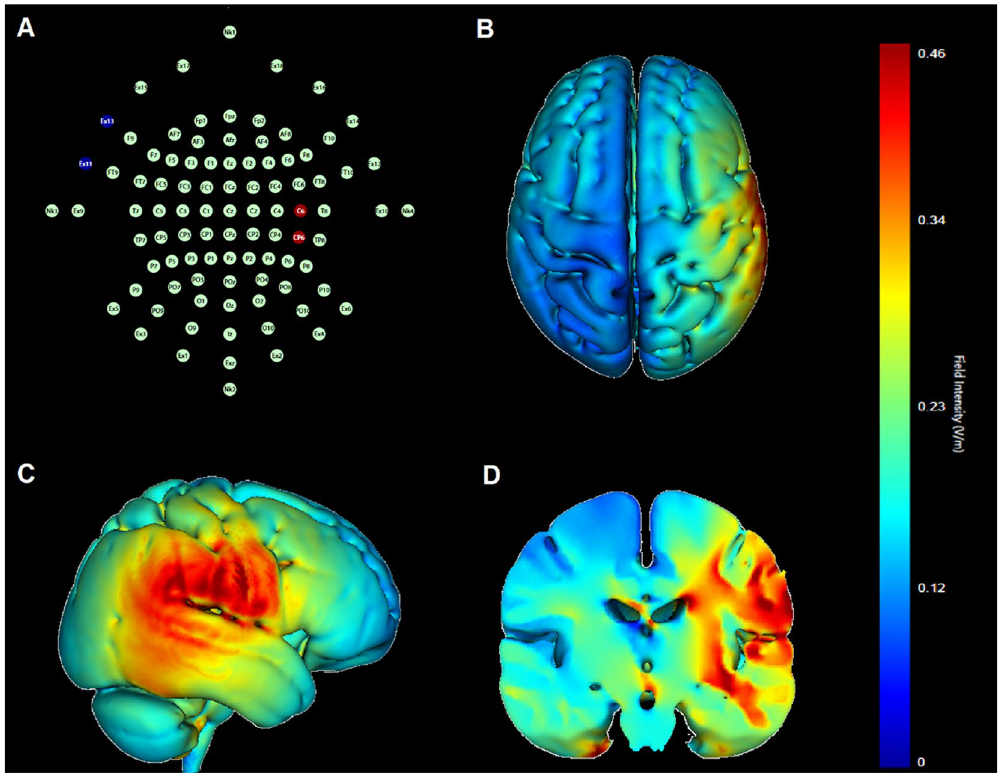
Figure 2. ( A ) An illustration of the stimulating electrodes positions based on the international 10–20 EEG system. ( B – D ) Simulation of the normalized electric field distribution in the brain: ( B ) superior view, ( C ) lateral view, ( D ) coronal